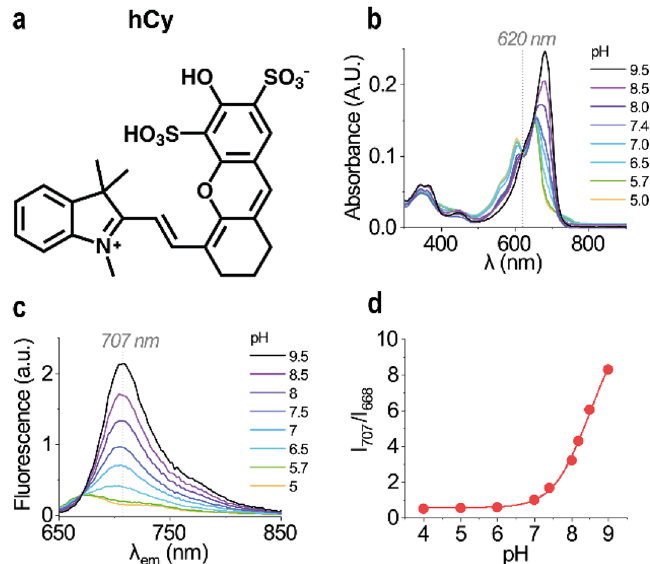
Figure 7. Alternative fluorescent dye to overcome bilirubin interference. ( a ) hCy structure; the product consists of a mixture of disulfonation isomers. ( b , c ) Absorbance ( b ) and fluorescence emission ( c ) spectra of free hCy in aqueous solutions of various pH ([hCy] = 10 μM). ( d ) Fluorescence intensity ratio I 707 /I 668 (λ exc = 630 nm) as a function of pH for free